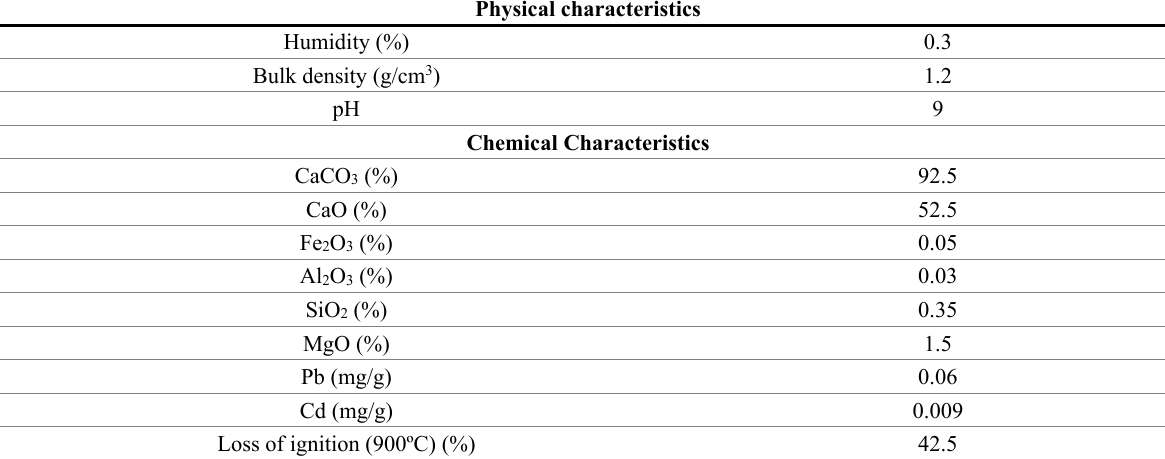
Table 3. Characterization of limestone filler used in the production of